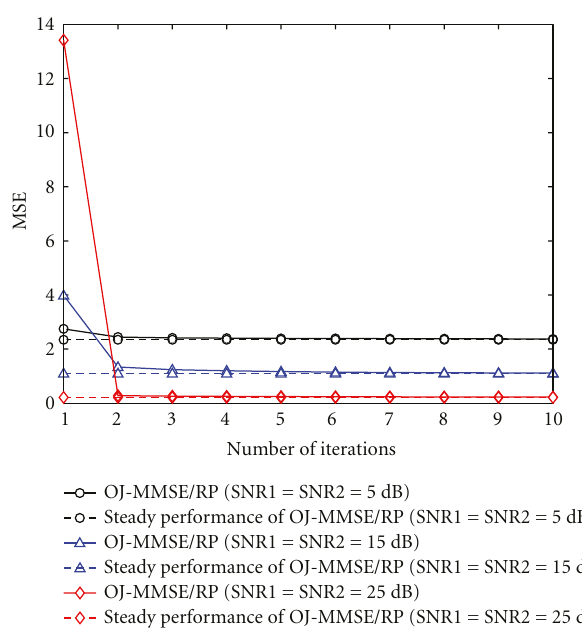
Figure 11: MSE performance versus number of